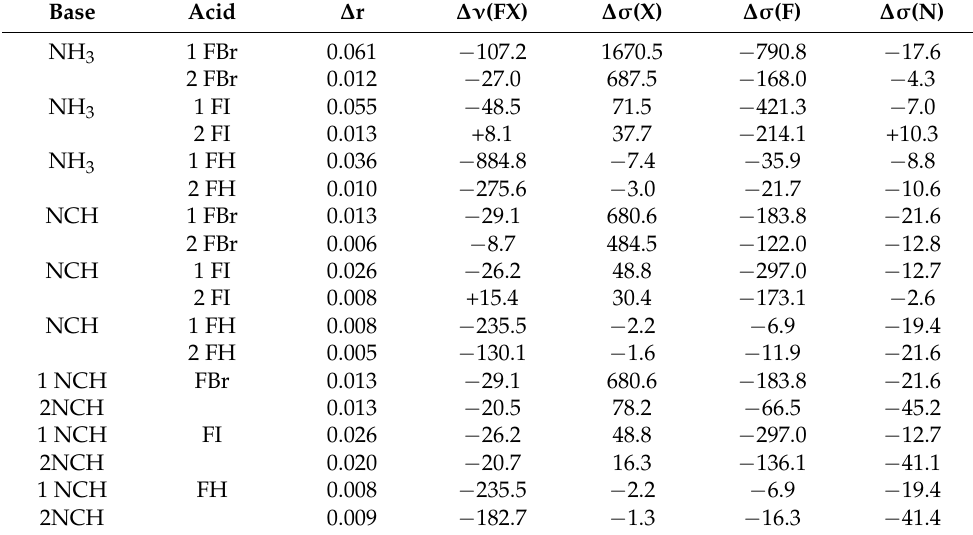
Table 3. Changes relative to monomer of internal bond length (Å), stretching frequency (cm − 1 ), and NMR chemical shieldings (ppm) in dyads and triads a